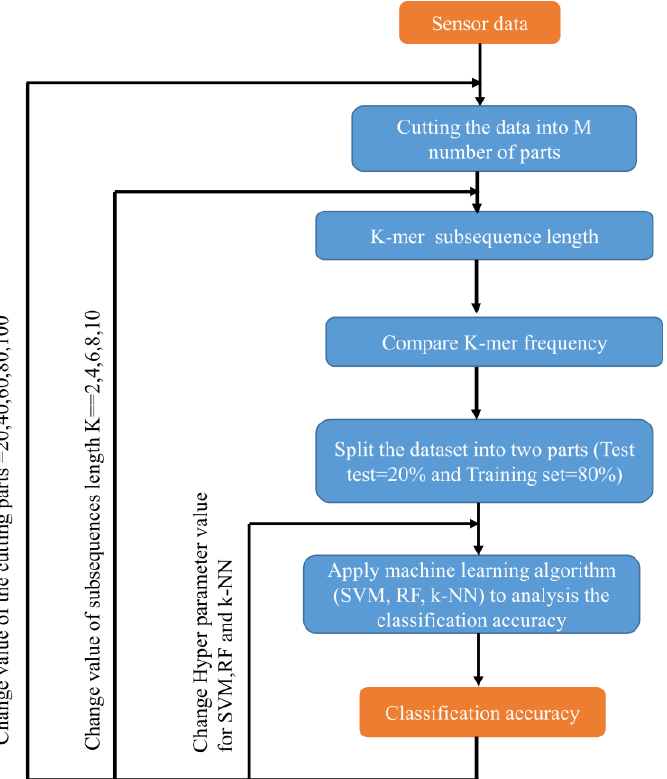
Figure 2. Flowchart of the proposed model.